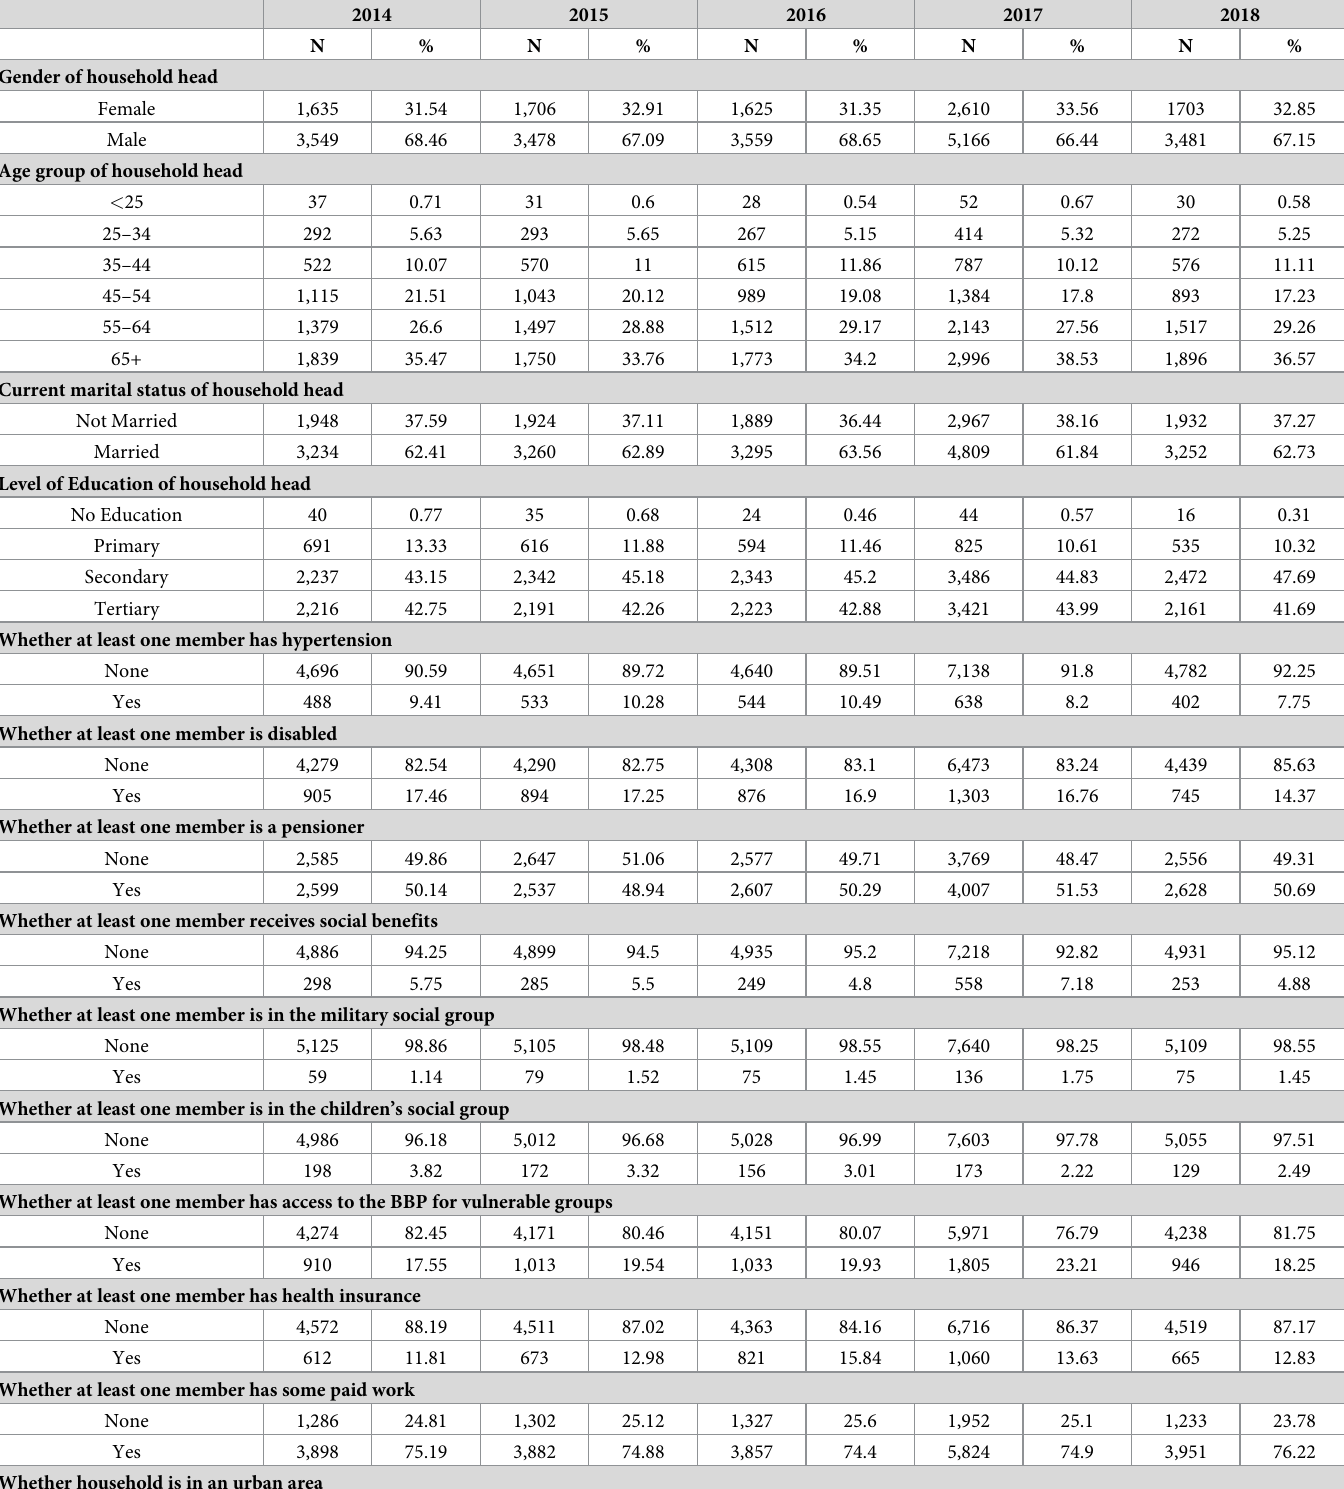
Table 1. Sociodemographic characteristics of surveyed